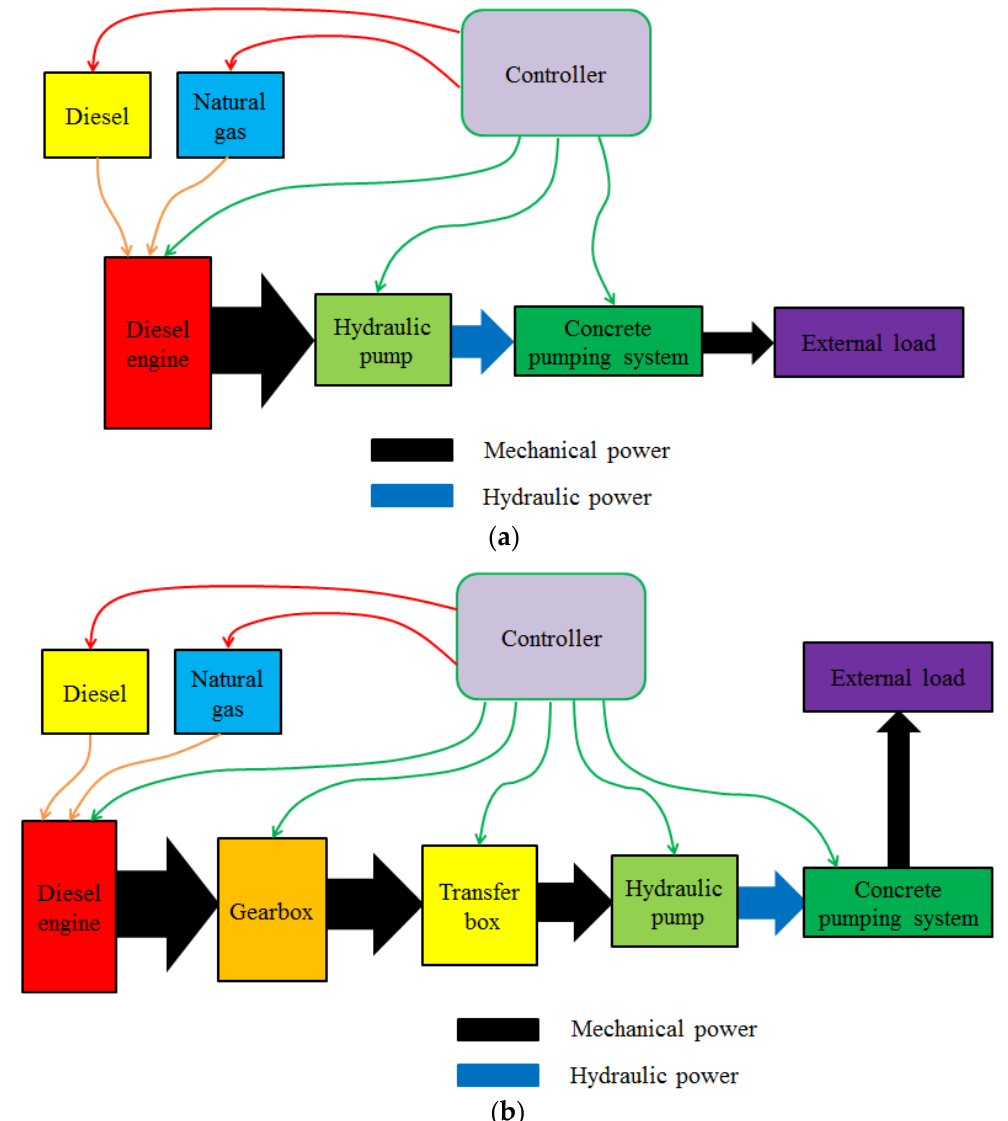
Figure 10. Schematic of dual-fuel approach of energy conservation for concrete pumps. ( a ) Dual-fuel approach of trailer concrete pump. ( b ) Dual-fuel approach of transported/truck-mounted concrete pump.